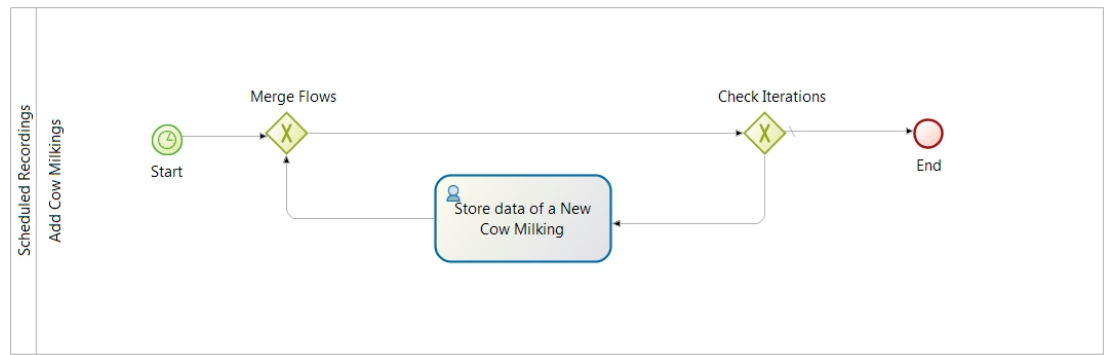
Figure 16. Diagram of the business process used to collect milking data of the farm herd.